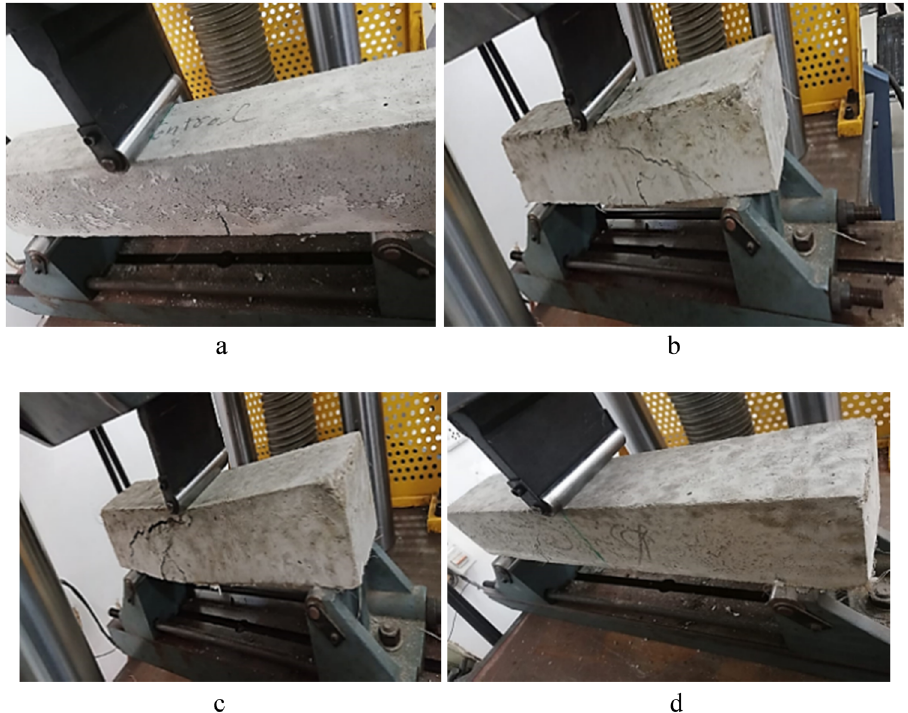
Figure 8: Failure pattern: ( a ) reinforced concrete without coir fi ber; ( b ) reinforced concrete with 0.5% coir fi ber; ( c ) reinforced concrete with